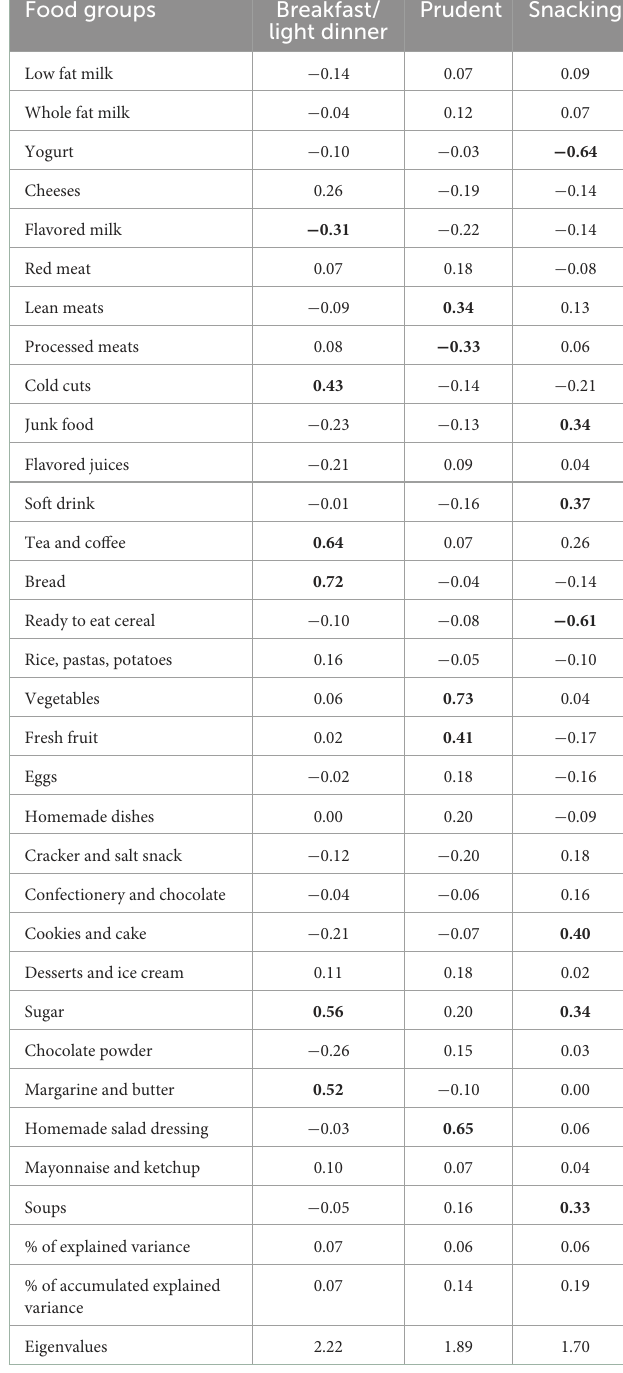
TABLE 1 Anthropometric, sociodemographic, and maternal characteristics TABLE 2 Factor loadings a , explained variance and eigenvalues of the three of 215 girls of the Growth and Obesity Chilean Cohort Study 2013–2017. major dietary patterns practiced by girls from the Growth and Obesity Chilean Cohort Study b n